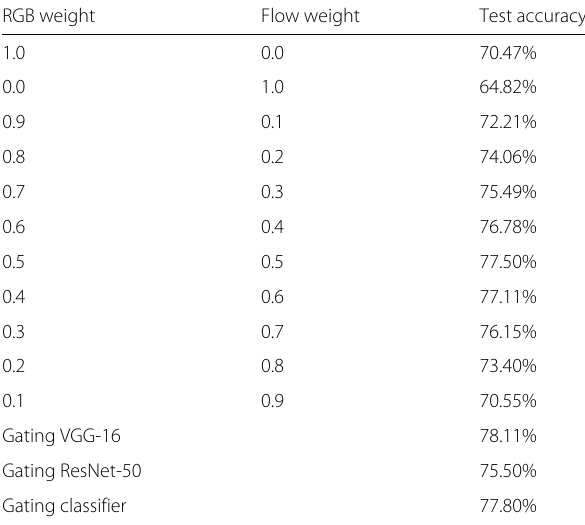
Table 5 ResNet-50, 80 epochs, on UCF-101 (split